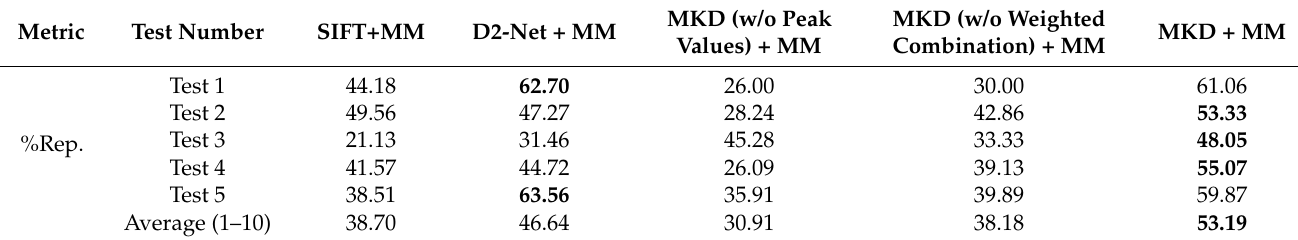
Table 4. Ablation experiment result of keypoints detection.